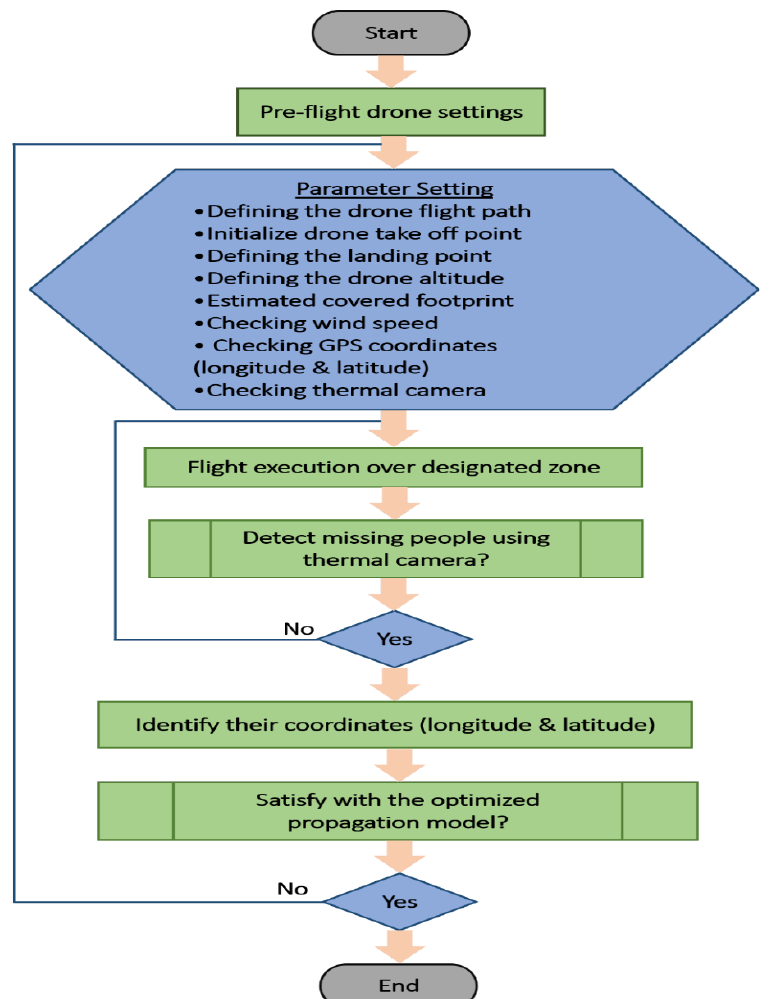
Figure 4. Flowchart of the proposed model and experiment setup.